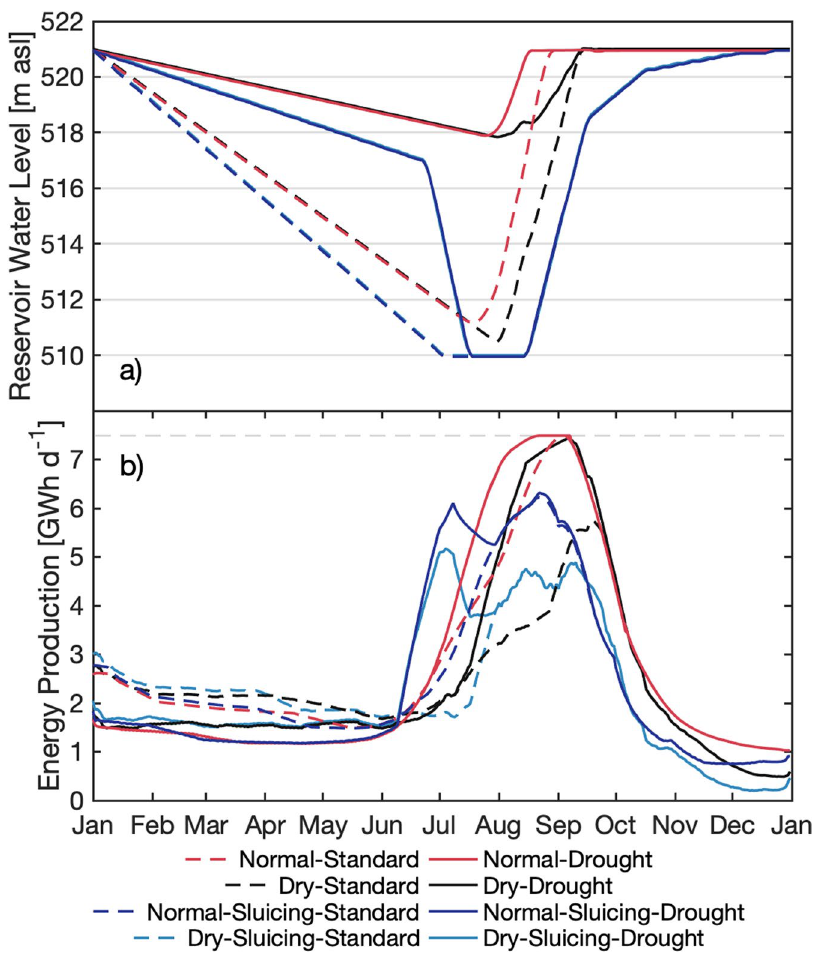
Figure 7. Reservoir management at the Upper Atbara Dam Complex in Sudan. (a) Reservoir water level (shown as 5-day moving average) and (b) energy production (shown as 30-day moving average) for a rainy season in a normal year without operation restrictions (red lines, “Normal”), for a rainy season under drought conditions without restrictions (black lines, “Dry”), for a rainy season in a normal year including sediment sluicing (dark blue lines, “Normal-Sluicing”), and for a rainy season under drought conditions including sediment sluicing (light blue lines, “Dry-Sluicing”, in (a) identical to dark blue line). The dashed lines denote reservoir management with standard reservoir operations. The solid lines show the altered reservoir management for drought conditions, i.e., having prior knowledge of drought. In (b) , the light gray dashed line 1 marks the maximum possible energy production (7.5 GWh d − ), i.e., the maximum reservoir capacity.